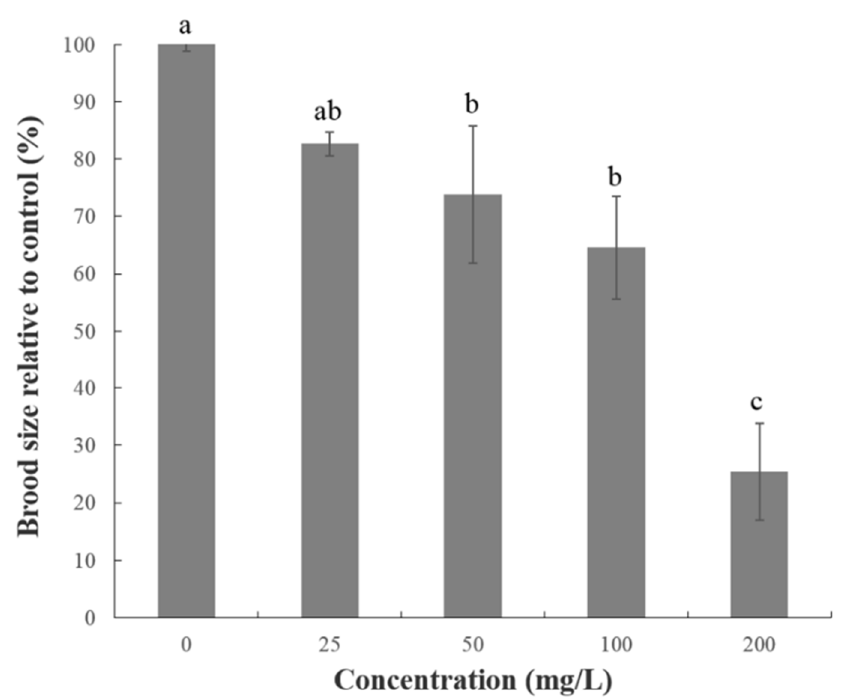
Figure 1. Reproduction assay of C. elegans immersed in FAc solution in various concentrations for 48 h. Data are shown as mean ± standard error ( n = 3), and different lowercase letters indicate significant difference among treatments by LSD test ( p < 0.05).